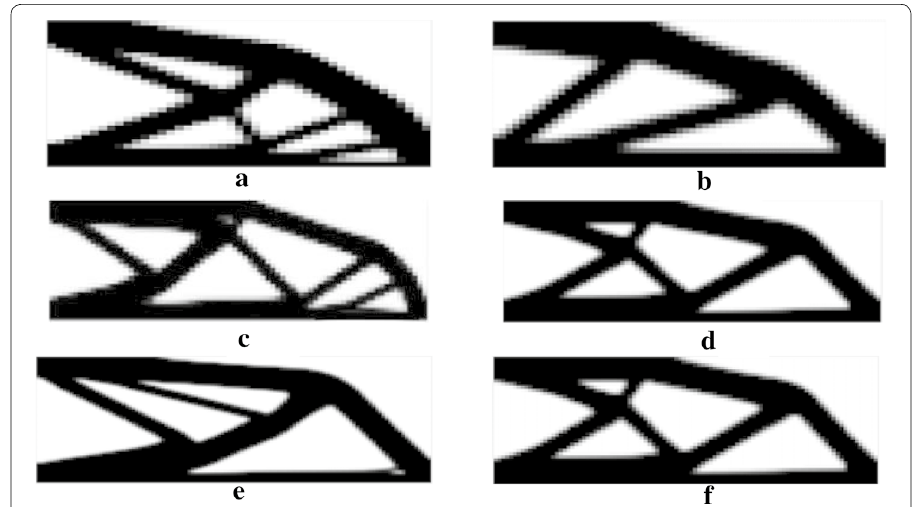
Fig. 12 Optimal material plots for numerous sizes of design domain a 45 100 40, e 120 60 and f 200 × ×